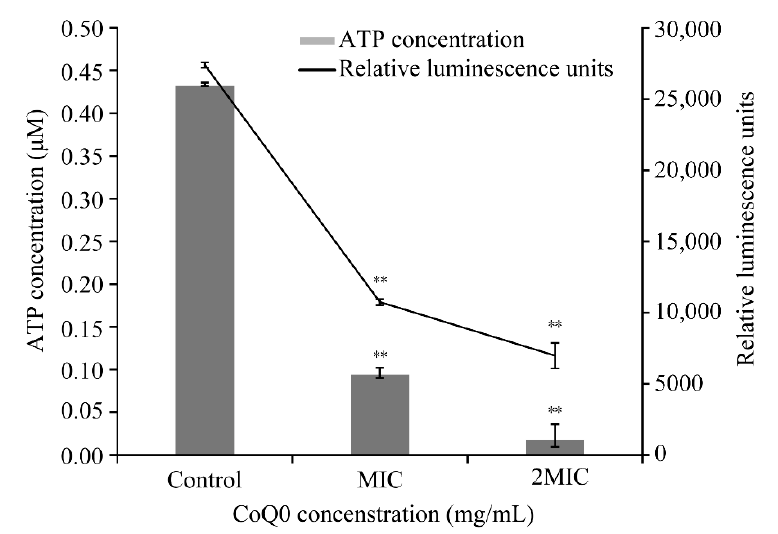
Figure 6. Effects of CoQ 0 treatment on intracellular ATP concentration of S. Typhimurium ATCC 14028. Values represent the means of triplicate measurements. Bars represent the standard deviation ( n = 3). Control represents no CoQ 0 added. ** p < 0.01 compared with the control.